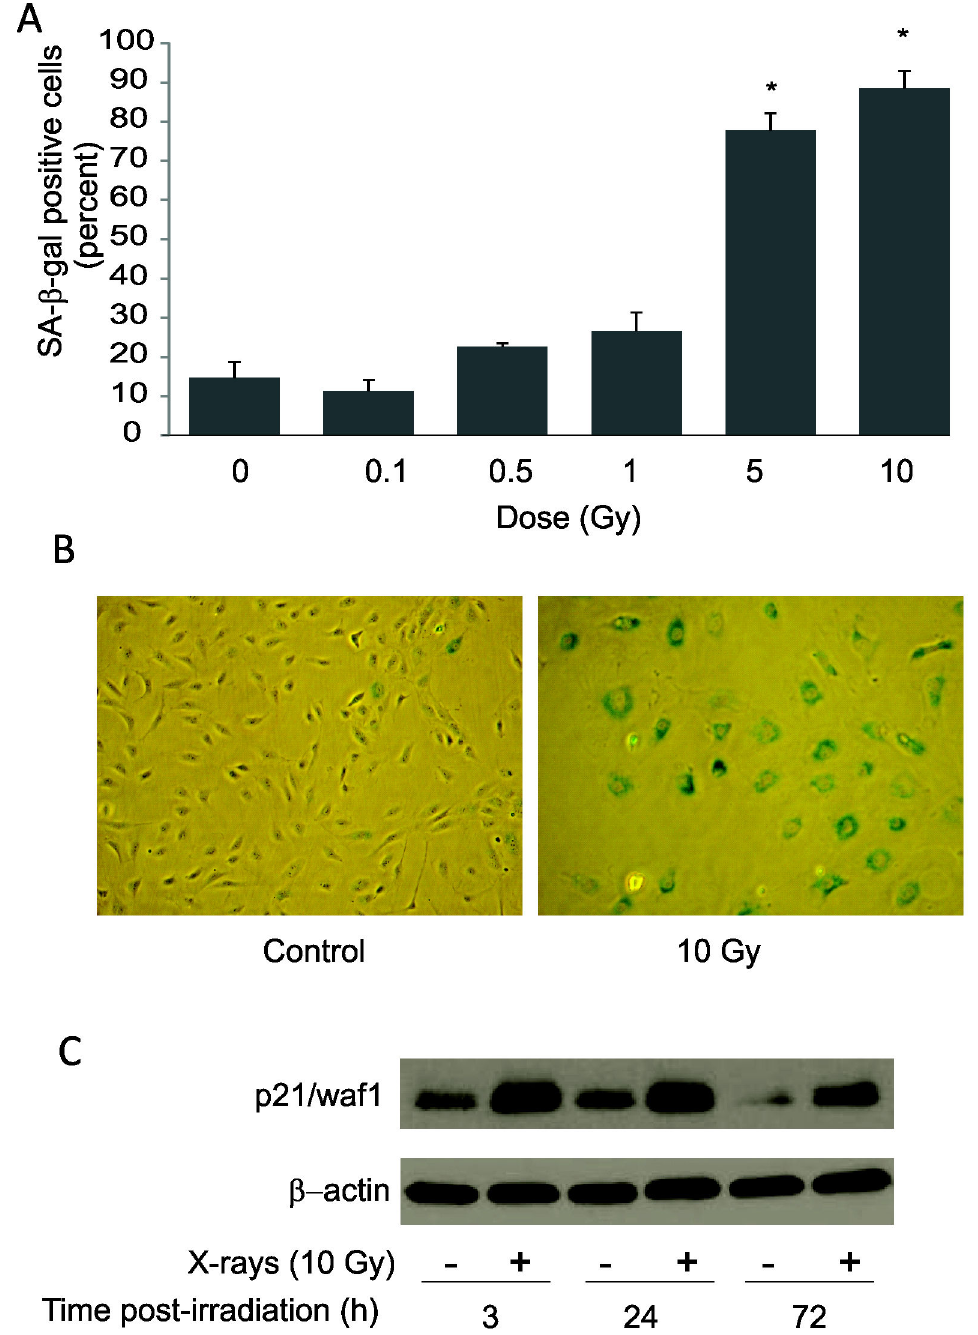
Figure 1. X-rays induce accelerated senescence in HPAEC. Subconfluent HPAEC were exposed to indicated doses of X-rays and then incubated until time of assay. (A) Dose-response effect of increasing X-ray doses in HPAEC. At 4 days post-irradation, irradiated and sham-irradiated HPAEC were assayed for SA-β-gal activity. Percentage of SA-β-gal positive cells was counted in at least 3 random fields. Graph represents means ± SEM, n = 3. * indicates statistical significance from controls, p<0.05. (B) SA-β-gal staining sham-irradiated and irradiated (10 Gy) (C) Time-course of p21/waf1 upregulation. Western blotting for p21/waf1 expression at indicated time-points post-irradiation.